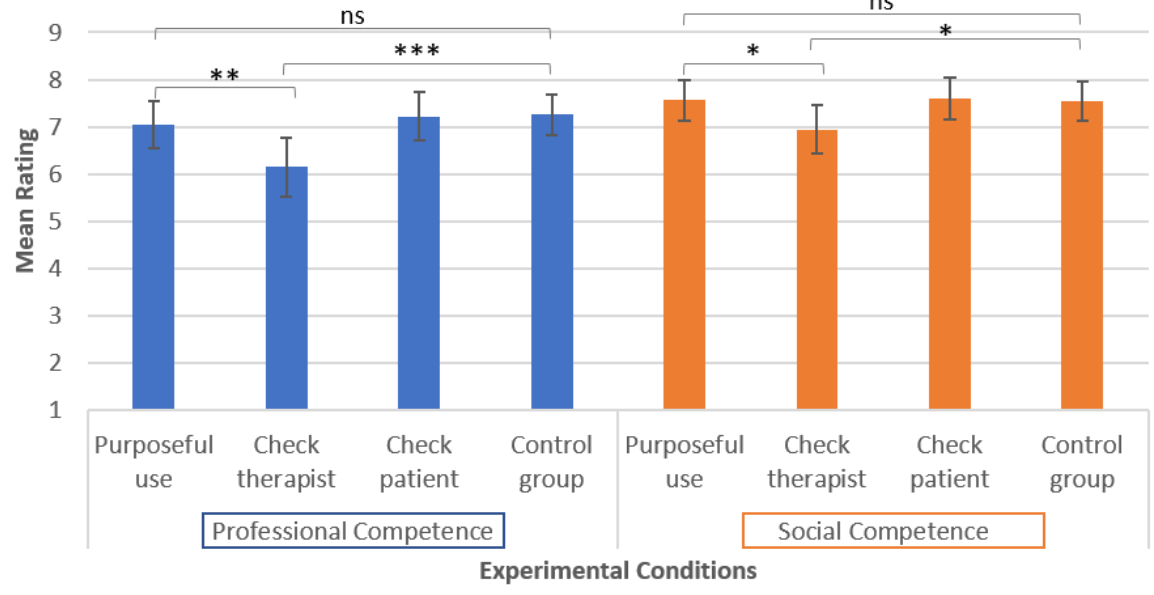
Figure 3. Means and CIs for the outcome variables professional competence and social competence in the four experimental conditions. ns: nonsignificant. * P <.05, ** P <.01, *** P <.001.